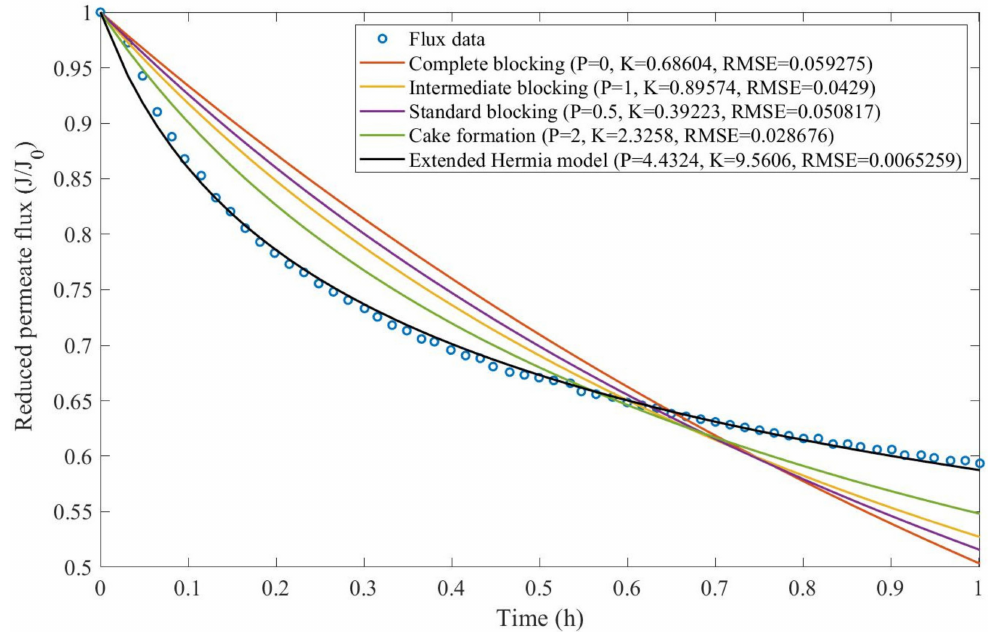
Figure A2. Model fitting for Coagulant 140 mg/L + HPI ultrafiltration considering the four original pore-blocking mechanisms and the extended Hermia model (14).